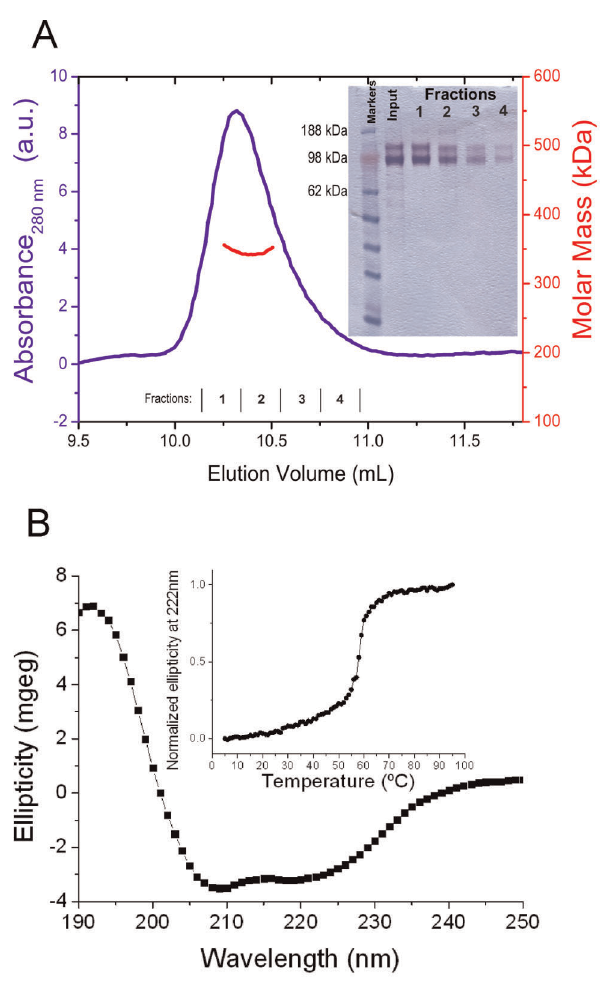
Figure 2. Structural analysis of rLCC111. Gel filtration chromato- gram profile, as measured by UV absorbance at 280 nm (blue trace), and molar mass (red trace), as measured by MALLS (only the data at the central part of the peak is shown, and can be read at the right hand axis, in red color) The mass measured at the centre of the peak is 335 kDa (A). The inset shows a coomassie stained SDS-PAGE under reduction conditions of the input and the indicated separately collected fractions. Circular dichroism spectrum recorded at 25 u C and thermal denaturation measured by the change in the ellipticity at 222 nm (B).